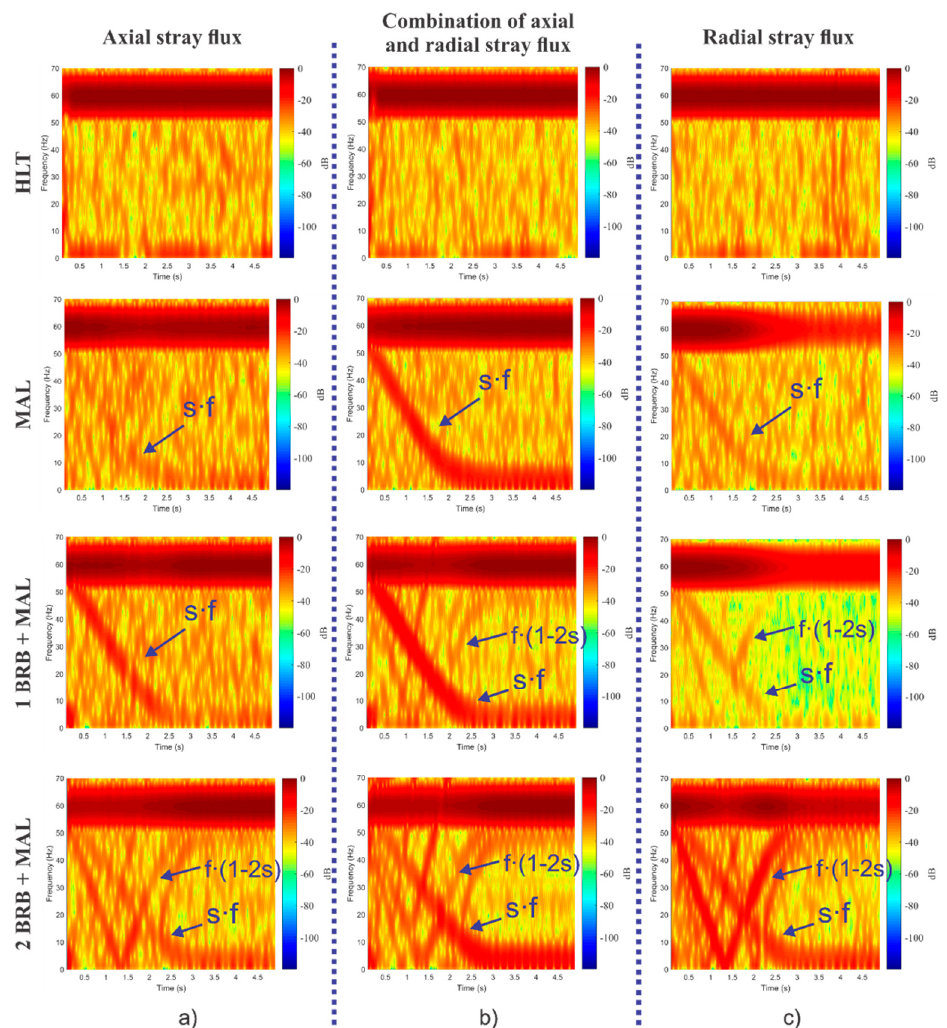
Figure 13. STFT analyses obtained for each one of the induction motor faults studied here when processing the signals provided by the triaxial stray flux sensor when installing it in position A: ( a ) primary sensor 1; ( b ) primary sensor 2; and ( c ) primary sensor 3.